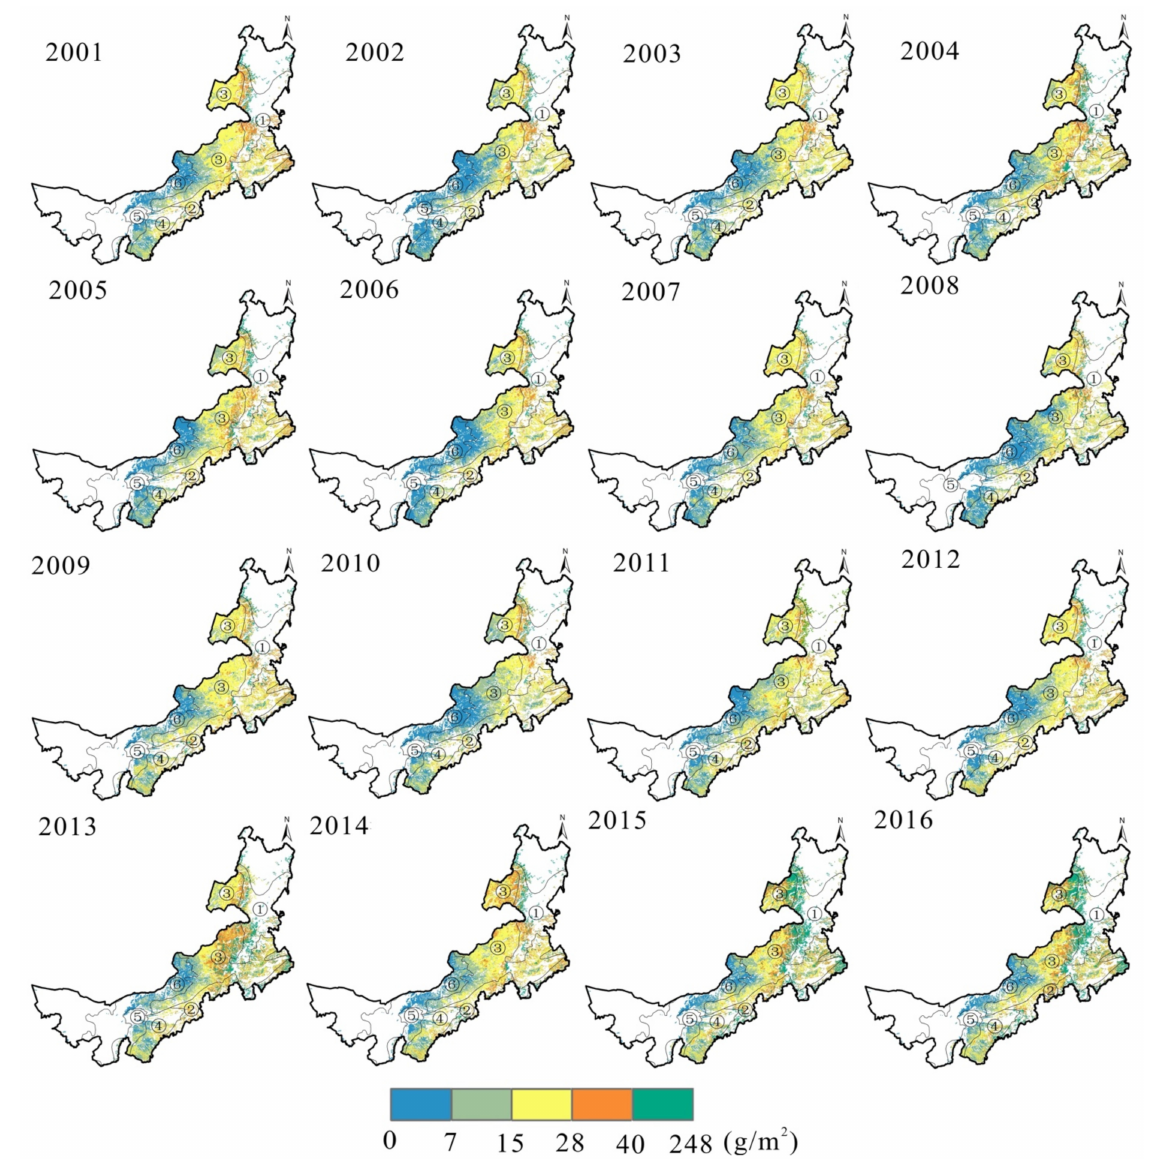
Figure 6. Annual average spatial distribution of combustible load in the grasslands area of Inner Mongolia during the nongrowing season from 2001 to 2016 (Note: 1 (cid:13) – 6 (cid:13) see Figure 1). The area with a combustible load between 7 and 28 g/m 2 comprised an average of 37.6% of this zone throughout a 16 year period. From 2001 to 2016, the combustible load per unit area of typical grasses in the southern temperate zone fluctuated predominantly between 0 and 28 g/m 2 , with an average area share of 92.1% in the region. The area with combustible loads between 7 and 15 g/m 2 had an average share of 33.9% in this region throughout a 16 year period, with the lowest and highest values occurring in 2015 and 2003, corresponding to values of 27.4% and 40%, respectively. From 2001 to 2016, the combustible load per unit area of southern temperate desert grasslands varied mostly between 0 and 28 g/m 2 , with an average area share of 99.9% in the region. The combustible load per unit area of temperate shrub and grasslands deserts generally ranged from 0 to 15 g/m 2 . From 2001 to 2016, grasslands comprised 98.5% of the area in Inner Mongolia. The area with combustible loads between 0 and 7 g/m 2 had a 16 year average share of 76.6% in the region, with minimum and maximum values in 2014 and 2006, equal to 58.5% and 95.4%,